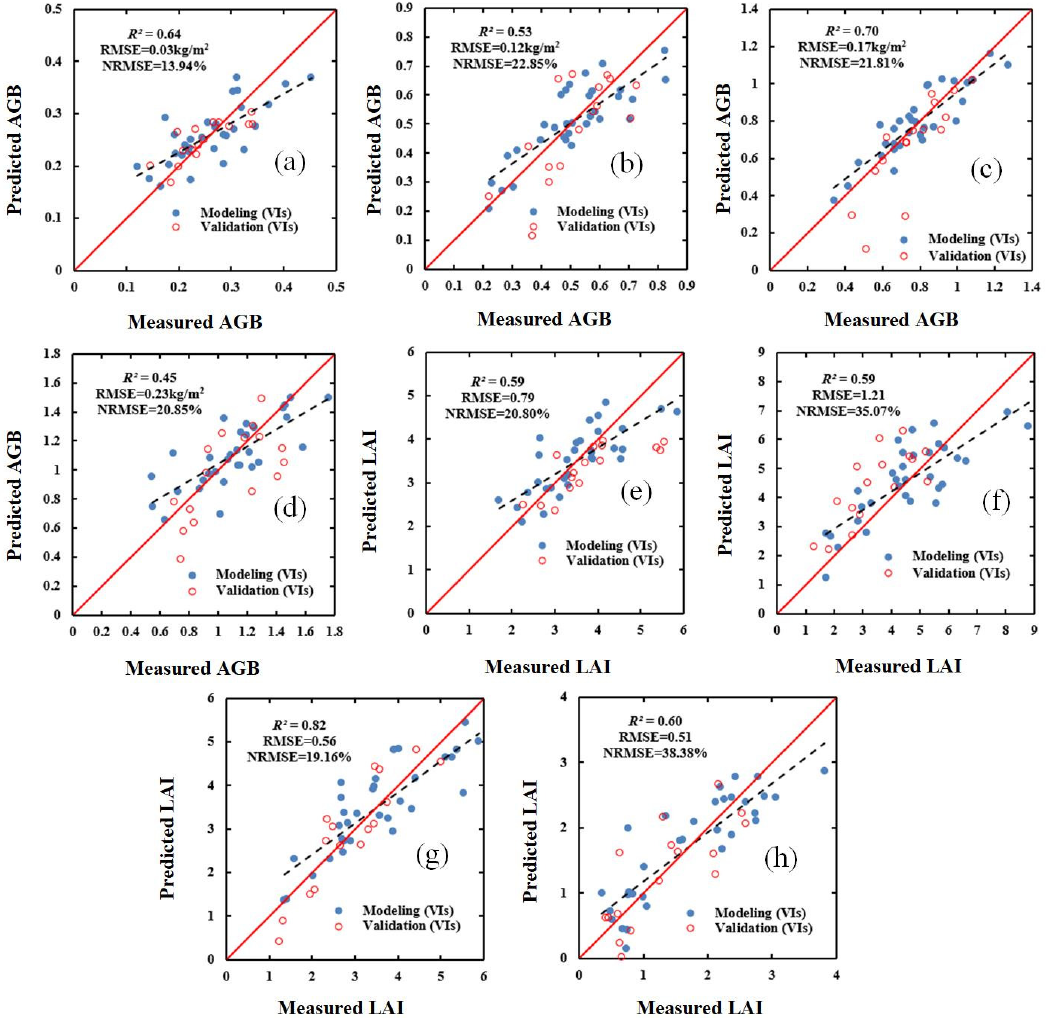
Figure 4. Relationship between ground-measured values of AGB (kg/m 2 ) and LAI (m 2 /m 2 ) in different growth stages of winter wheat and the values predicted based on VIs and PLSR: ( a ) AGB (jointing stage); ( b ) AGB (flagging stage); ( c ) AGB (flowering stage); ( d ) AGB (filling stage); ( e ) LAI (jointing stage); ( f ) LAI (flagging stage); ( g ) LAI (flowering stage); and ( h ) LAI (filling stage).